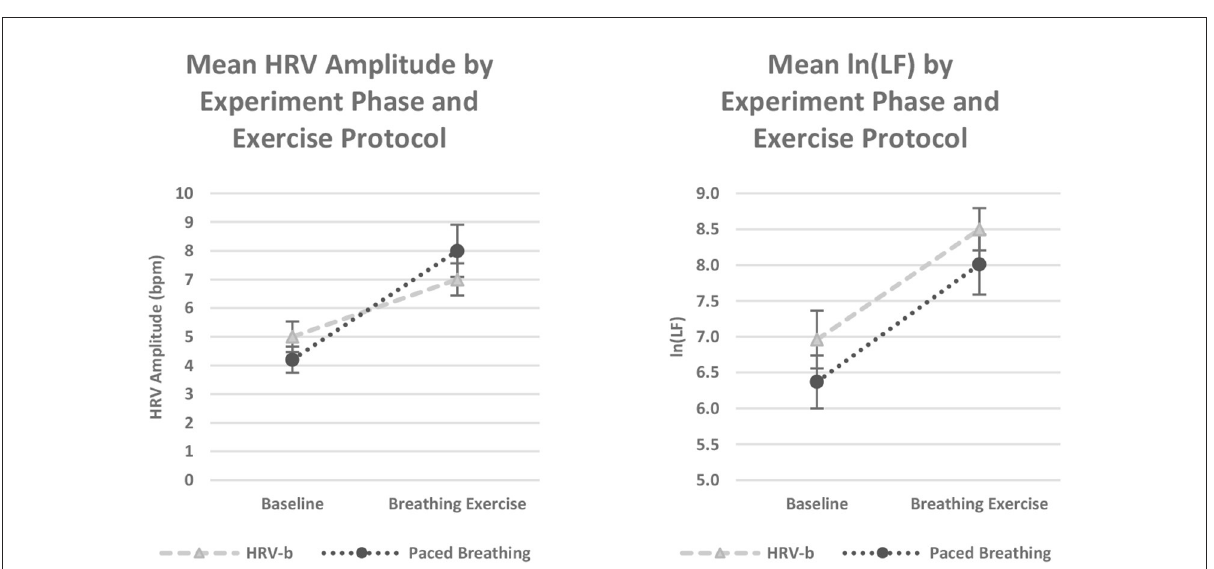
FIGURE7 HRV Scores broken down by Experiment Phase and Exercise Protocol (HRV-b – gray dashed lines; Paced Breathing – black dotted lines). (Left) HRV Amplitude; (Right) ln(LF). No significant differences were detected between the two protocols. However, a significant experiment phase x exercise protocol interaction was detected with HRV amplitude. Error bars depict standard error of mean (SEM).